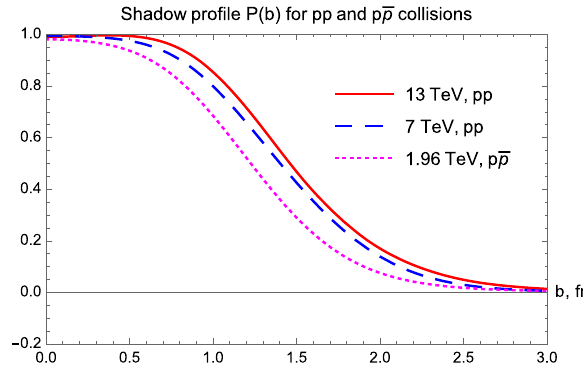
√ s = 53 GeV to 1.96 TeV